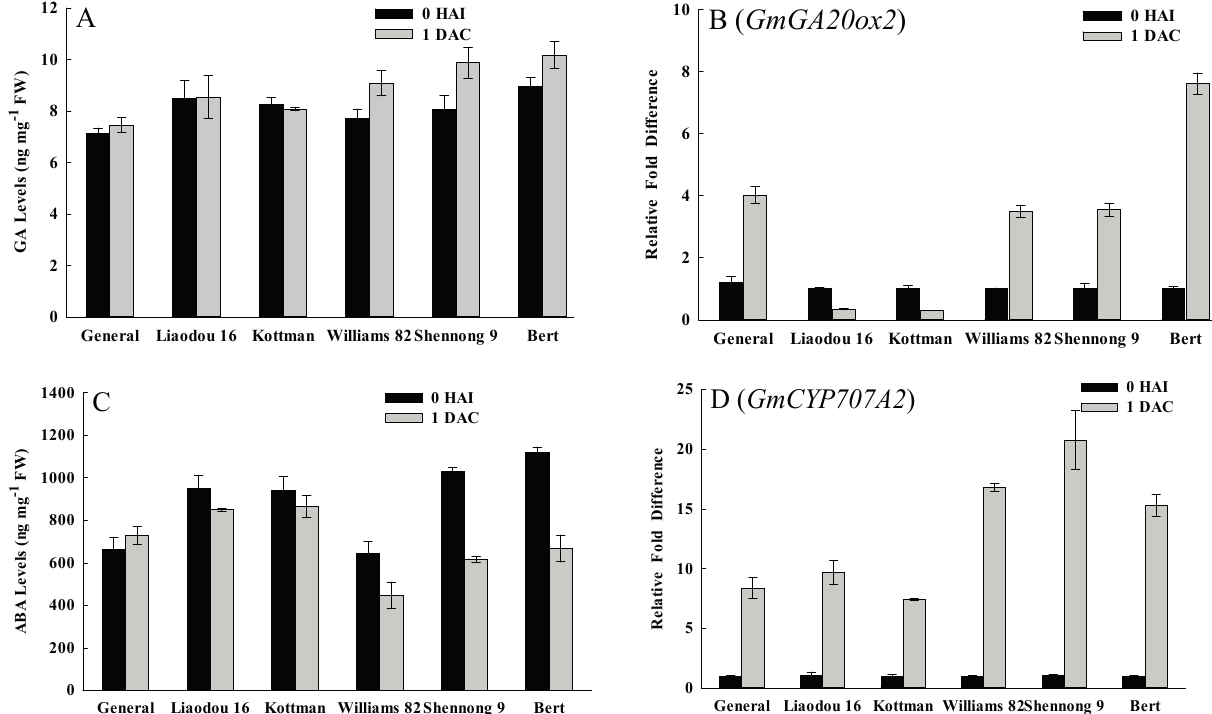
Figure 3. Comparisons of gibberellin (GA) and abscisic acid (ABA) levels, and the expression levels of genes ralated to GA and ABA metabolism between different genotypes. The values represent means ± SD based on three biological replications. ( A ) GA content in cotyledonary nodes after 0 h of infection and after 1 day of co-cultivation; ( B ) qRT-PCR analysis of GA synthetic gene GmGA20ox2 ; ( C ) ABA content; and ( D ) qRT-PCR analysis of ABA catabolic gene GmCYP707A2